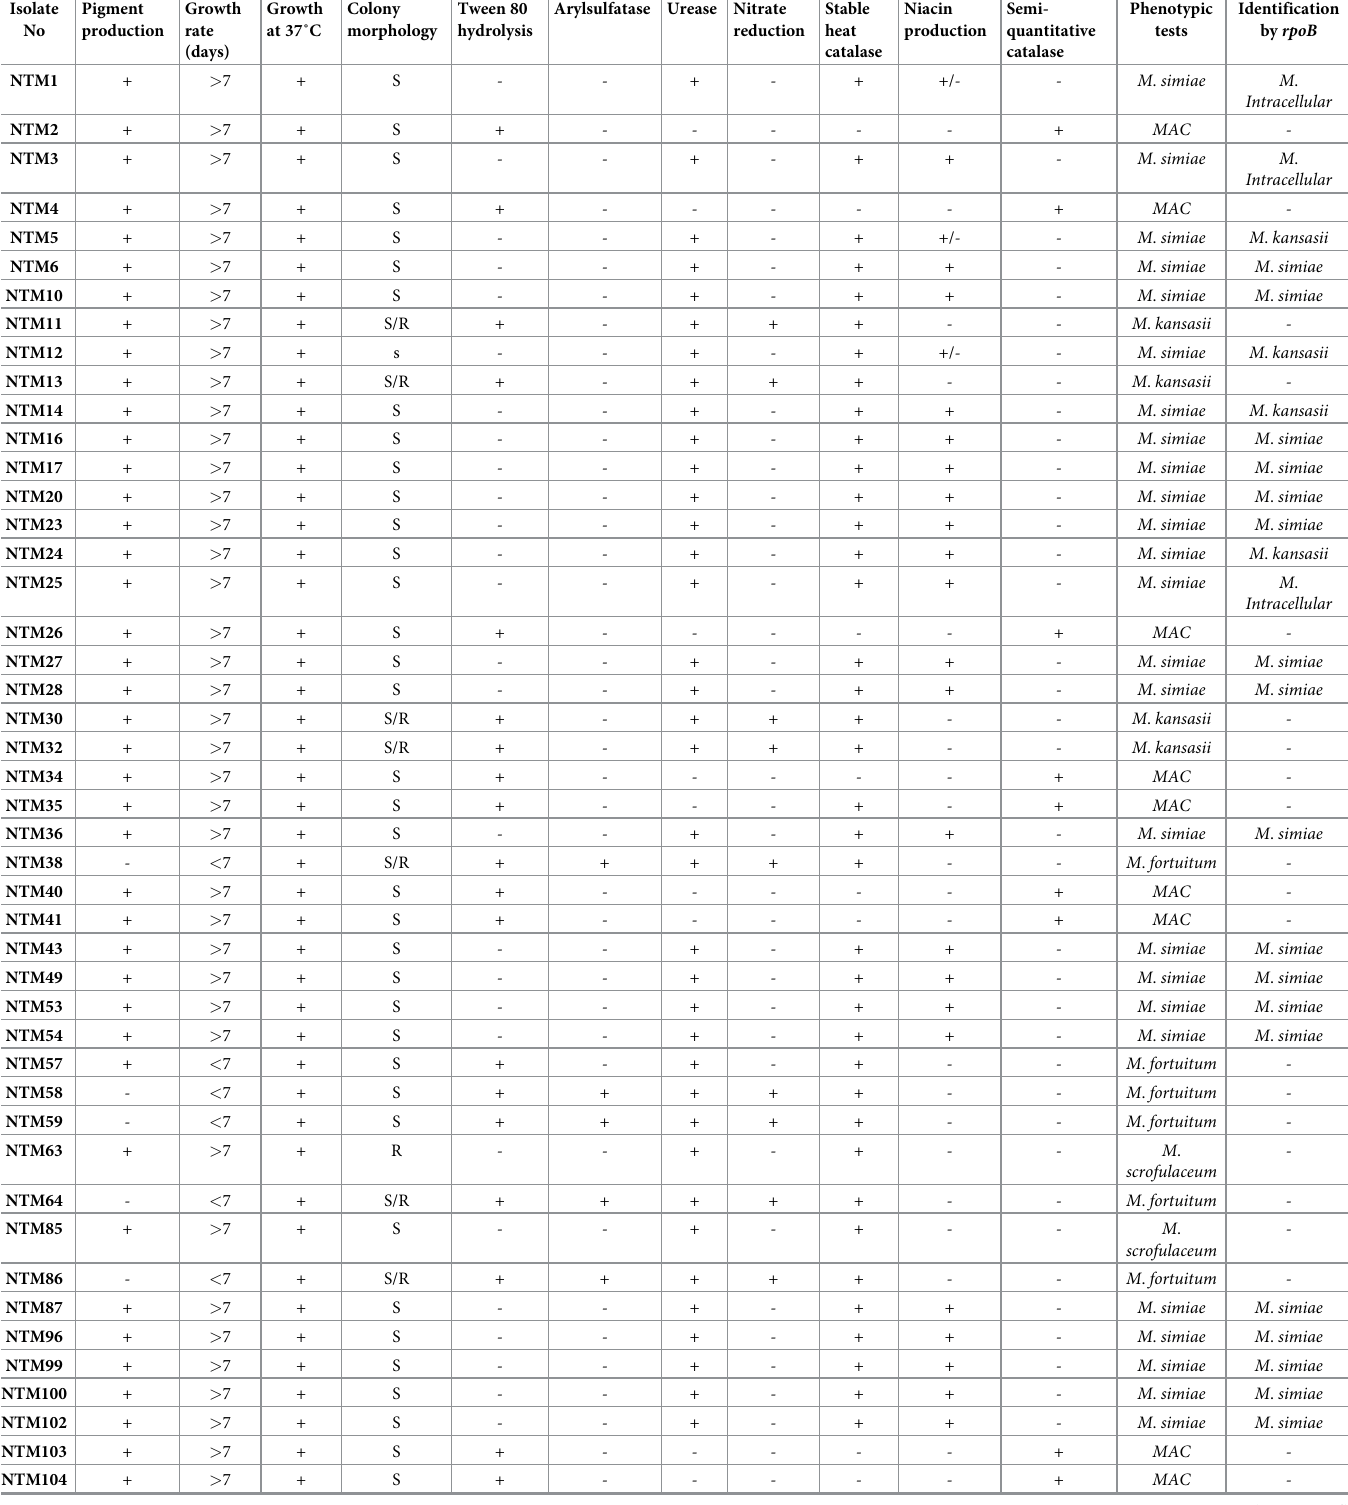
Table 4. Results of M . simiae identification by phenotypic characteristics and molecular tests. Isolate Pigment Growth No production